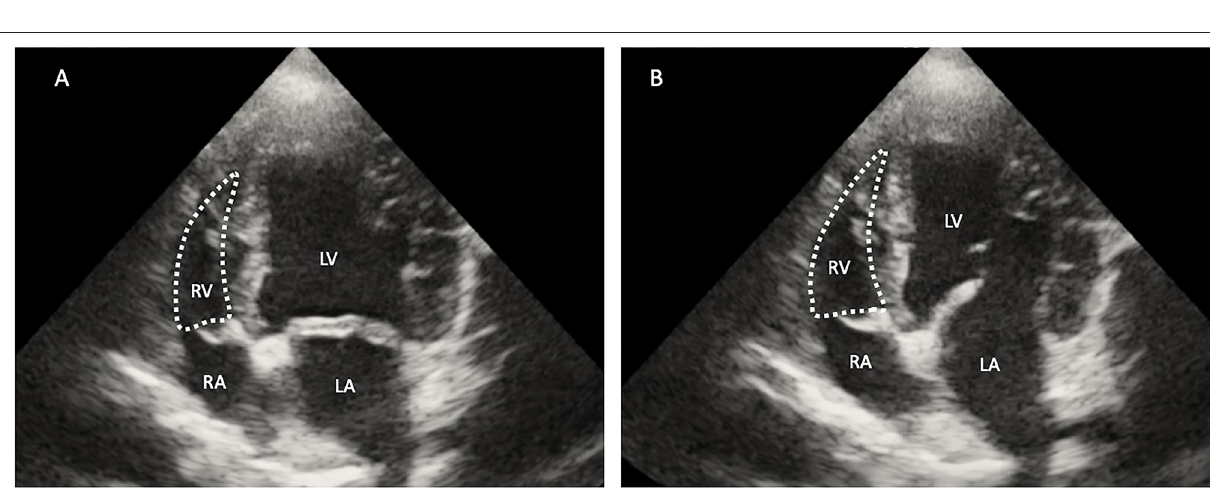
FIGURE 3 | Two-dimensional echocardiographic image of the right ventricular area (RV) during systole (A) and diastole (B) . The right fractional area change (FAC) was calculated using the formula [(RV diastole – RV systole)/RV diastole] × 100. RA, right atrium; RV, right ventricle; LV, left ventricle; LA, left